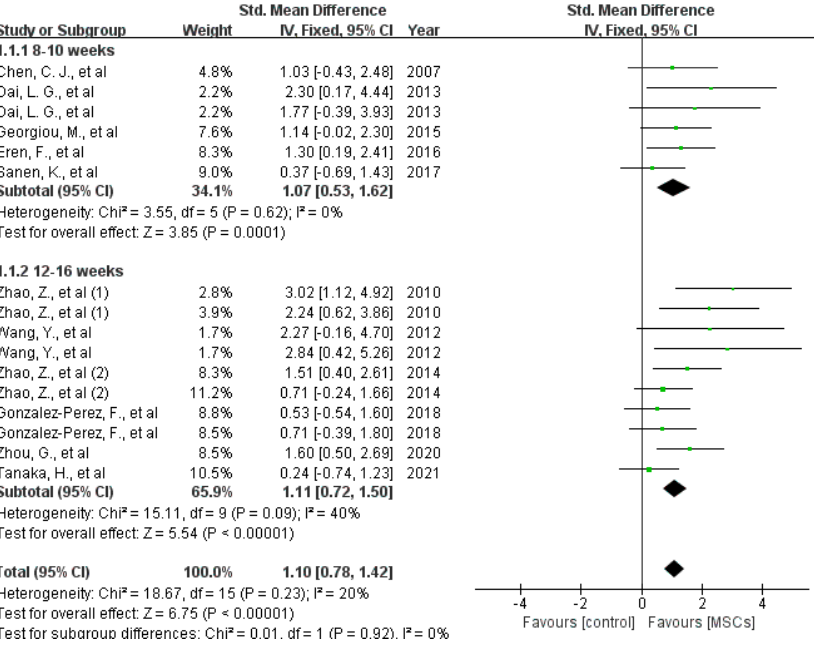
Figure 8. The forest plot shows the effect of MSCs on myelin thickness (middle and distal parts of the nerve defects) 12 weeks after surgery [5,11–36]. Plots on the left ‐ hand side indicate favoring MSCs or MSCs ‐ loaded scaffolds, while plots on the right side indicate favoring placebo ‐ control treatment or blank scaffolds. 4. Discussion This study aimed to systematically review the preclinical evidence for using MSCs to regenerate critical ‐ sized peripheral nerve defects in experimental rats in vivo. Despite dif ‐ ferences in donor species, delivery routes, and cell dosage, most included studies showed that the application of MSCs resulted in significantly better outcomes in terms of promot ‐ ing nerve regeneration, improving nerve function, and preventing muscle atrophy. The SFI, conduction velocity, muscle weight, myelin thickness, and fiber count represent a va ‐ riety of assessments for nerve regeneration, and for most of the assessed studies, MSCs were beneficial for these outcomes. However, a direct comparison between methods used in different studies is difficult due to the heterogeneity of outcome measures. From the five afore ‐ listed outcome measures, only Zhou et al. (2020) used four in their results, Hou